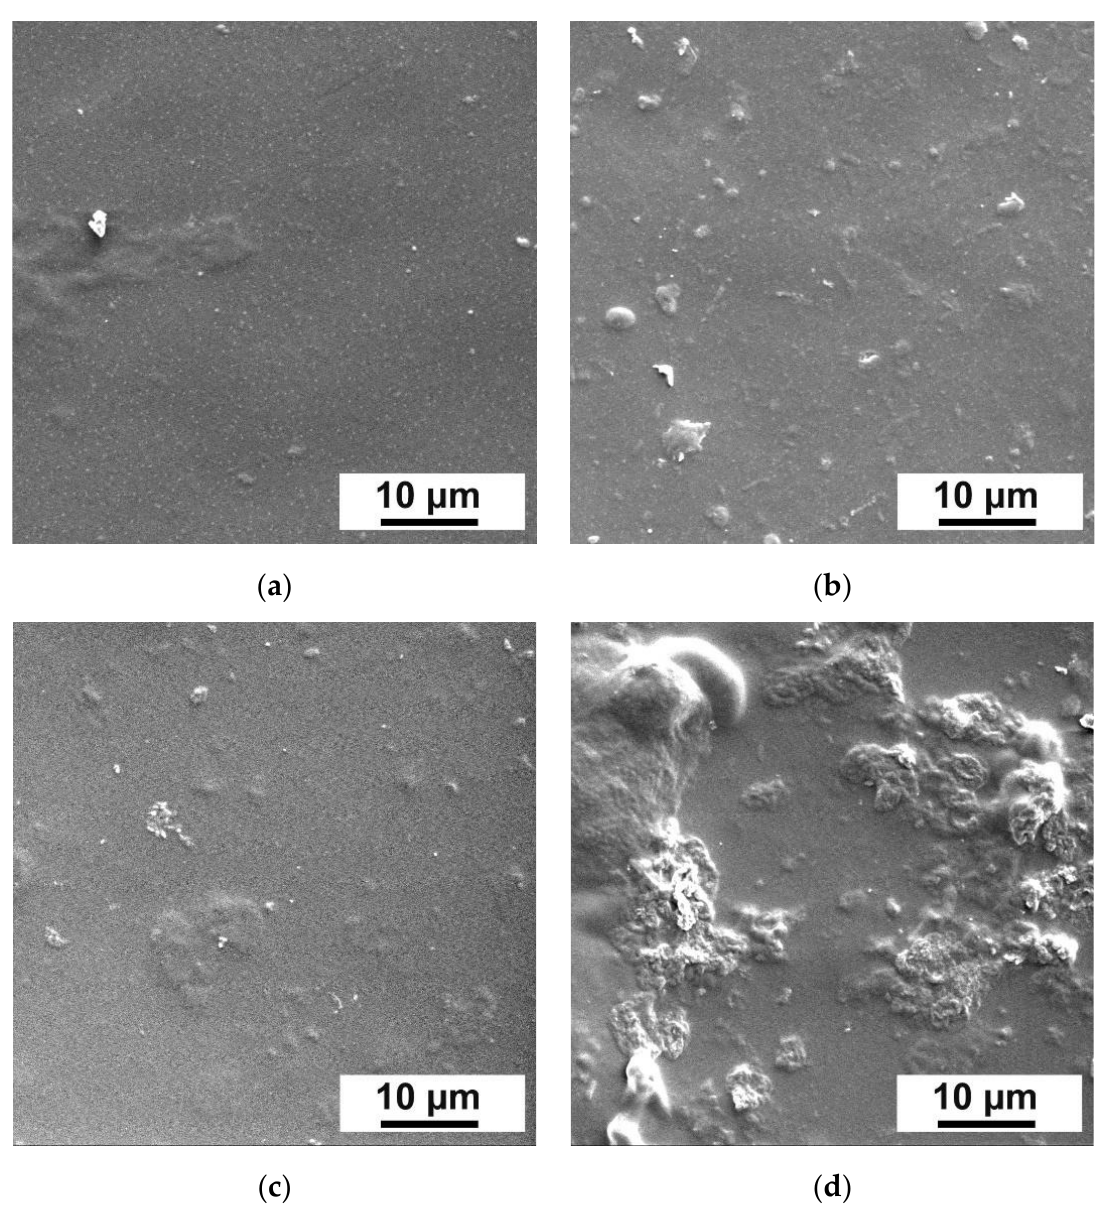
Figure 3. SEM microphotographs of the surface of selective layers of dynamic composite